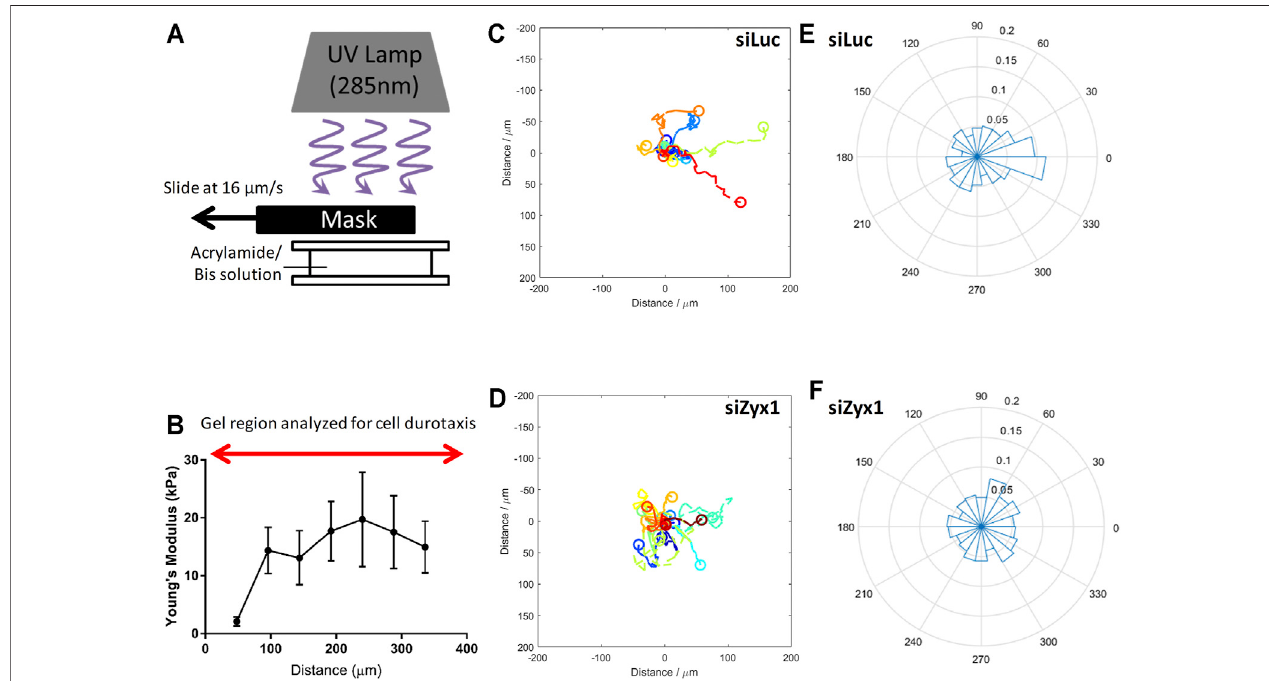
FIGURE5| Zyxin-knockdownNIH3T3cellsdonotexhibitdurotaxis (A) Illustrationofmethodusedtofabricategradientpolyacrylamidegels (B) Young ’ smodulusofthe polyacrylamidegradientgelasafunctionofdistance.TrajectoriesofNIH3T3cellstransfectedwith (C) controlsiLuc(n (cid:2) 15)and (D) siZyx1siRNA(n (cid:2) 16)overperiodof6 h. Different colors represent the celltrajectories for each cell. Rose plot showing direction cellmigration ofNIH3T3 cells transfected with (E) control siLuc and (F) siZyx siRNA.